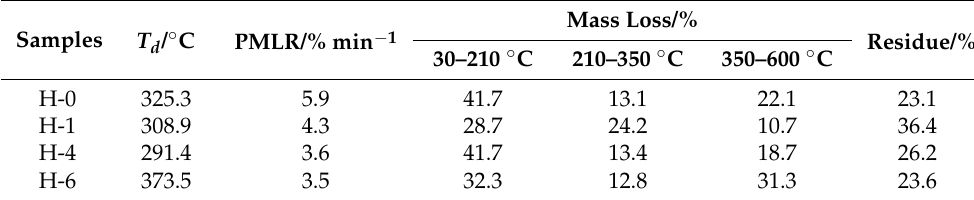
Table 2. TG data of transparent flame-retarded hydrogels. ( T d represents the initial degradation temperature when mass loss is 50%, PMLR stands for peak mass loss